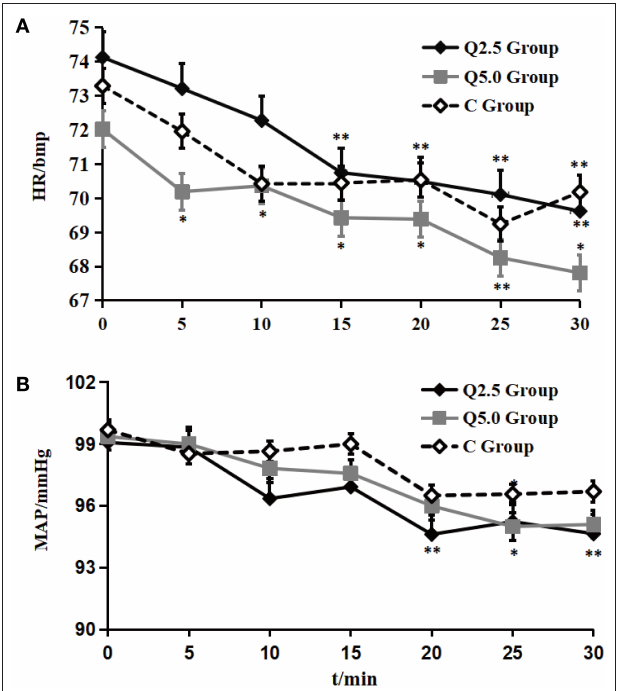
FIGURE 2 | Hemodynamic changes before (0min) and after epidural injection. Data are expressed as the mean (SD); C group: ropivacaine alone, Q2.5 group: ropivacaine combined with low-dose (2.5mg) oxycodone; Q5.0 group: ropivacaine combined with high-dose (5.0mg) oxycodone; (A) Changes in HR; (B) Changes in MAP; Dunnett T3 test: * P < 0.05, ** P < 0.01, compared with the baseline.